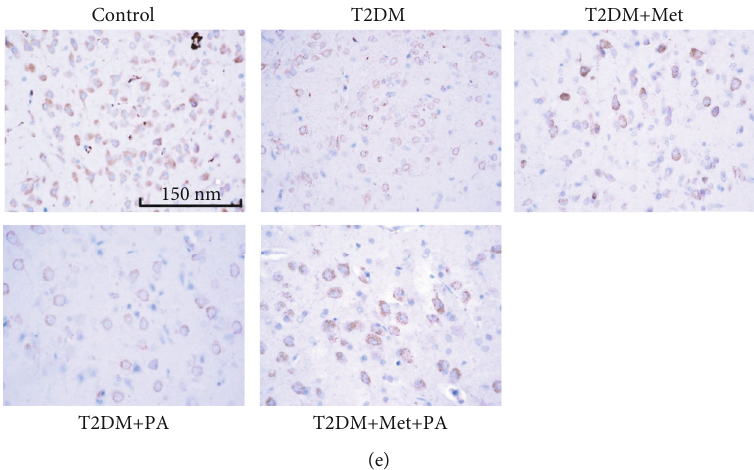
Figure 6: E ff ects of administration of metformin and PA on the level of unfolded protein response regulator GRP78/BiP. (a) Immunoblotting analysis of GRP78 in rat VMH: representative immunoblots are shown and quanti fi ed using tubulin as a loading control for hypothalamus lysates. (b) The bar graphs of GRP78 are presented as means ± SEM ( n = 6/group ). (c) Quantitative polymerase chain reaction (PCR) of Grp78 in rat VMH: data were normalized to β -actin and pooled from three independent experiments ( n = 6 rats/group). Immunocytochemical analysis of GRP78-positive VMH cells: representative (d) histogram and (e) images are shown. DAB staining was used to visualize GRP78-positive cells; Hematoxylin Gill was used for nuclear staining. Scale bars indicate 150 μ m (magni fi cation × 400). All data are shown as means ± SEM ; ∗ p < 0 : 05 vs. control, ∗∗ p < 0 : 05 vs. T2DM, # p < 0 : 05 vs. metformin administration, and @ p < 0 : 05 vs. PA